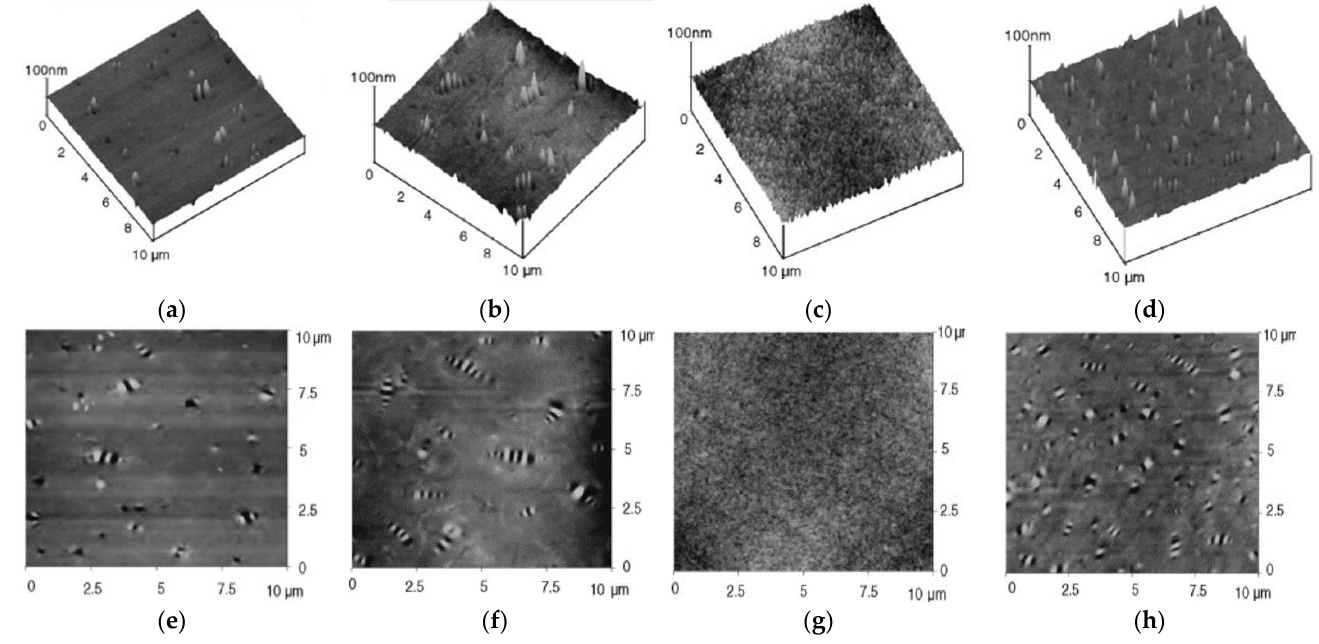
Figure 4. The three-dimensional and two-dimensional AFM images: ( a ) three-dimensional, unaged AH70; ( b ) three-dimensional, PAV aging AH70; ( c ) three-dimensional, unaged PG76; ( d ) three-dimensional, ( e ) two-dimensional, unaged AH70; ( f ) two-dimensional, PAV aging AH70; ( g ) two-dimensional, unaged PG76; ( h ) two-dimensional, PAV aging PG76; PAV: 1200 h, 60 °C and air pressure at 2.1 MPa. Reprinted with permission from [72]. Copyright © 2022 Elsevier.